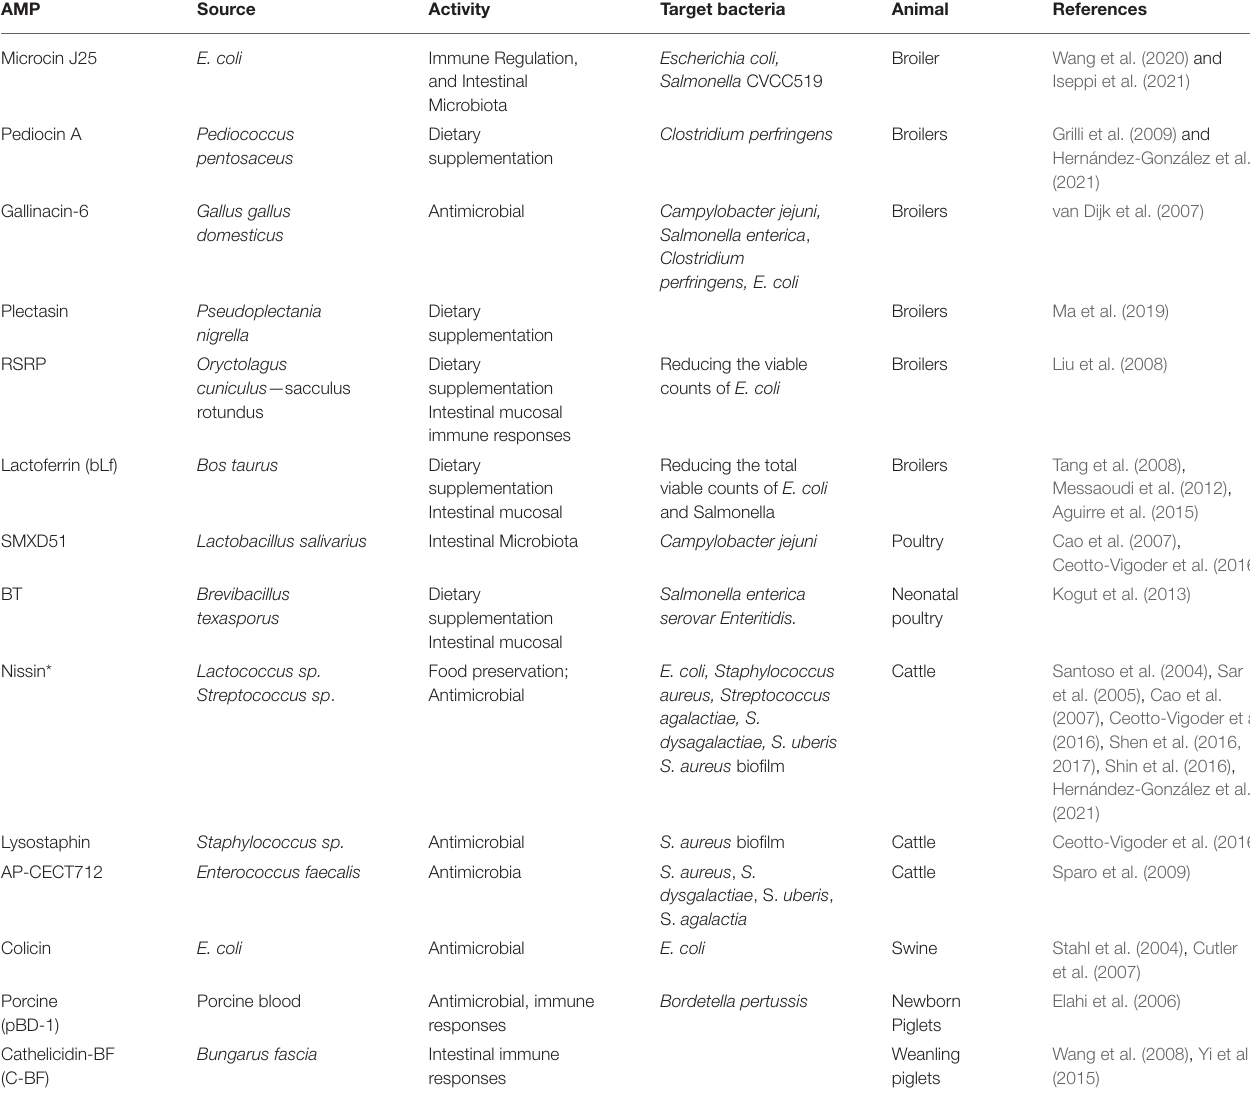
TABLE 3 | AMPs using livestock